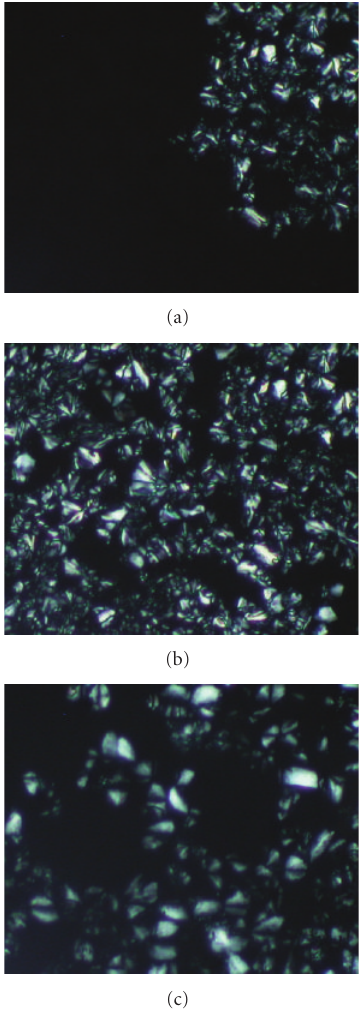
Figure 12: Polarized optical micrographs of cholesteryl acetate dispersed in UV15 taken during heating from the solid phase at (a) 25 ◦ C, (b) 110.1 ◦ C, and (c) 111.2 ◦ C.